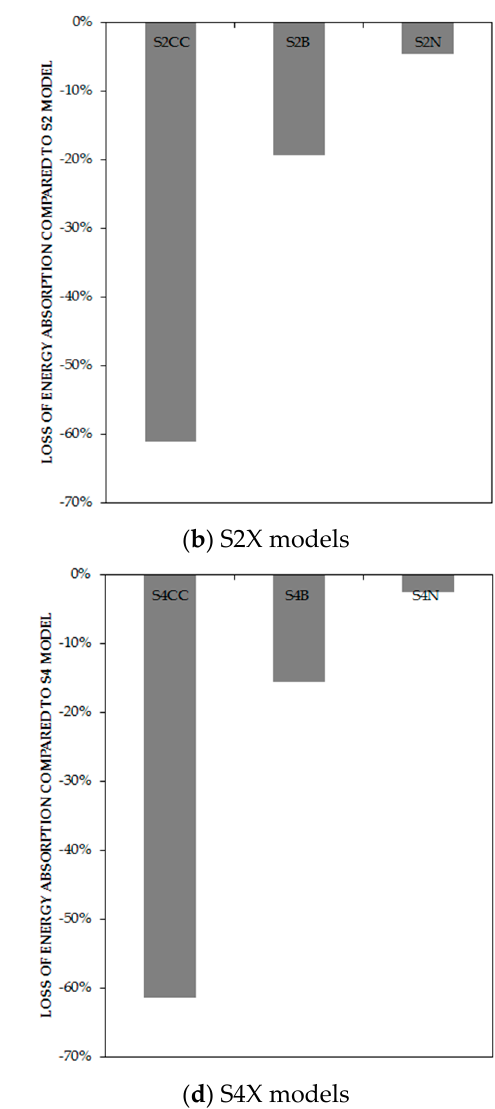
Figure 9. Loss of ultimate strength of models based on the type of connections in comparison with full-connection models by percentage.